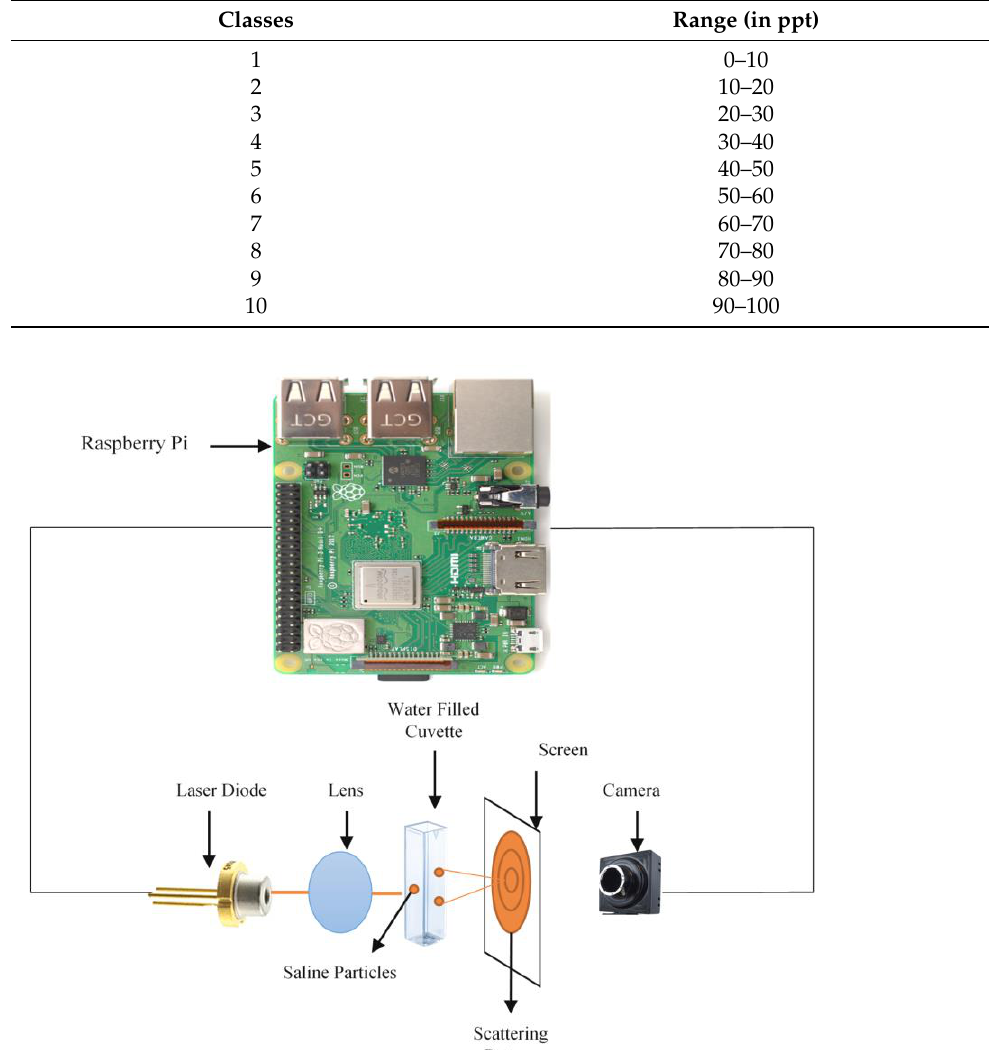
Figure 2. The architecture of the fine-tuned VGG-16 model. Initially, the training images were converted to grayscale images to simplify the computation task. Then, the input images were reshaped to the required dimensions of 224 × 224 × 3 for the input of the model. The layers of the model were frozen so that the model only trained the added layers. The data augmentation technique was applied to the training set due to its limited size. Table 2 formulates the various transformations applied to the training images. Furthermore, the images were split into training and testing data in the ratio 70:30, respectively. Customized parameters tabulated in Table 3 were used to perform network training and intricate pattern and design learning. According to Table